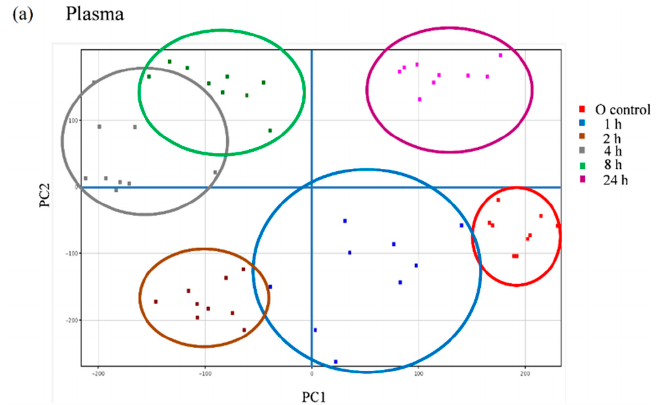
Figure 6. Cont. Figure 6.